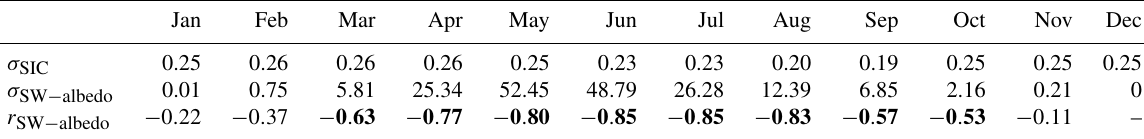
Table 1. The spatial standard deviation of SIC anomalies σ SIC and net shortwave radiation anomalies due to the albedo effect σ SW − albedo (Wm − 2 ) over the Arctic Ocean. r SW − albedo is the correlation coefficient between SIC and shortwave radiation anomalies. Those significant at a 99% confidence level are given in bold.